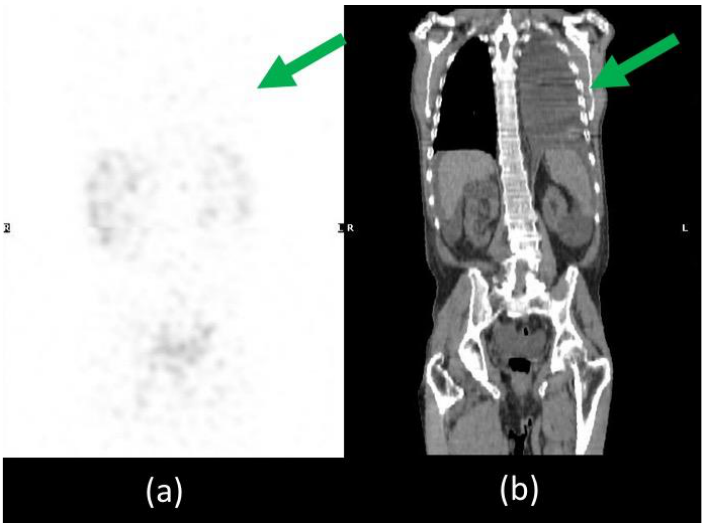
Figure 5. SPET/CT whole body lymphoscintigraphy. MIP image ( a ) did not show any radiotracer uptake in the left pleural effusion visible on CT coronal image ( b ), excluding the presence of chylothorax (green arrow).